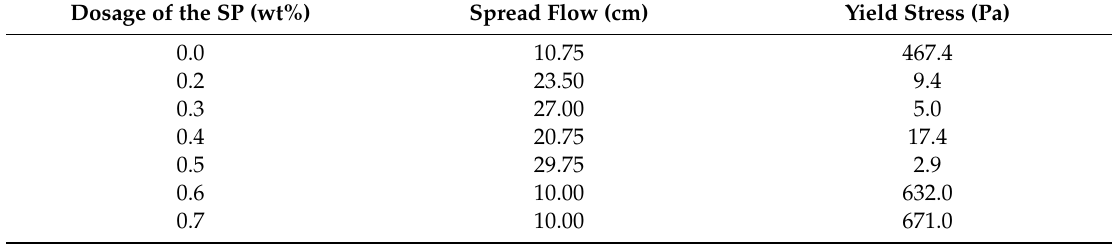
Figure 3. Composition of the hardened CEM I after an infinite duration of hydration (w/c = 0.36). Table 3. Spread flow of CEM I with di ff erent dosages of superplasticizer (SP) (water / cement, w / c = 0.36) measured by a spread flow test and calculated yield stress (by Roussel).